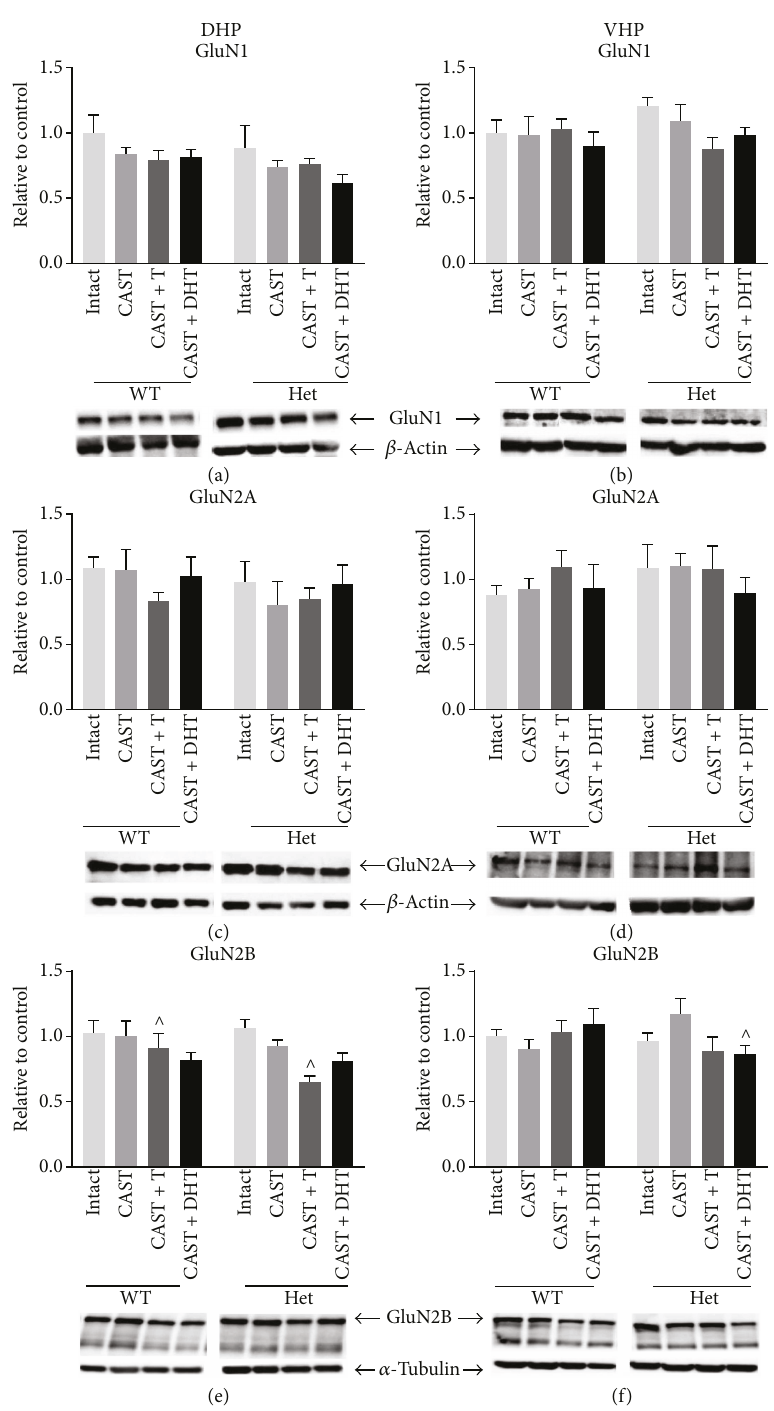
Figure 3: Protein expression of NMDA receptors in the dorsal (DHP) and ventral (VHP) hippocampus of male sham castrated+placebo (intact), castrated+placebo (CAST), CAST +testosterone (T), and CAST+ dihydrotestosterone- (DHT-) treated mice. (a) GluN1 expression in the DHP, (b) GluN1 expression in the VHP, (c) GluN2A expression in the DHP, (d) GluN2A expression in the VHP, (e) GluN2B expression in the DHP, (f) GluN2B expression in the VHP. Representative blots for each NMDA receptor subtype as well as the loading control. N =5 – 7 per treatment group. ^ p < 0 1 . Error bars represent the standard error of the mean (SEM). Two-way ANOVA was performed. ^ above the CAST+ hormone-treated bars represents post hoc trend showing a di ff erence between CAST +hormone-treated groups and CAST